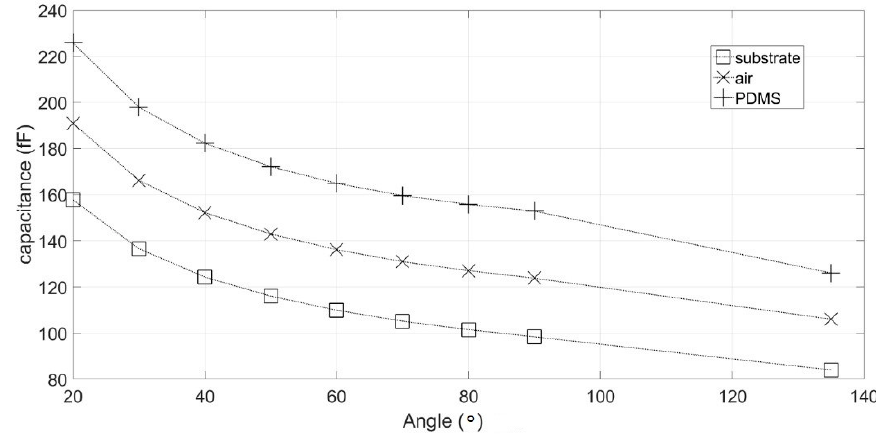
Figure 4. Simulated sensor capacitance as a function of electrodes angles and material.